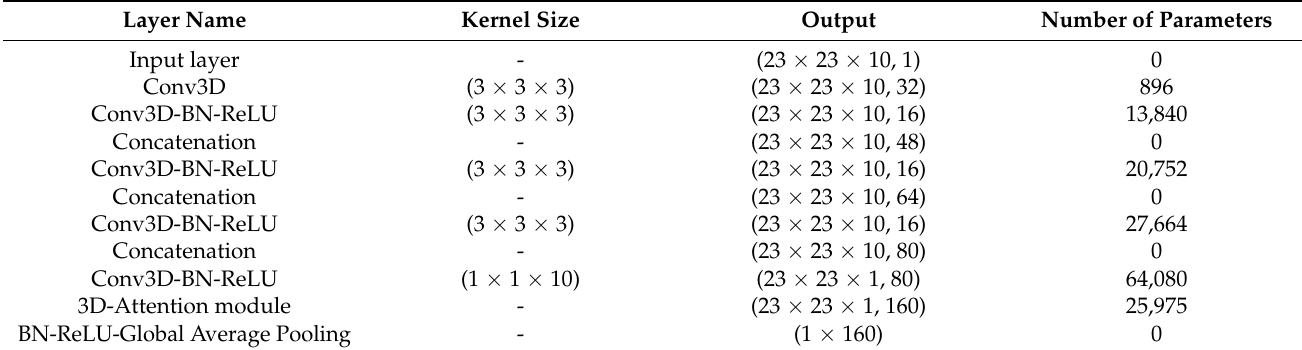
Table 5. Details of the 3D-DenseNet with dual attention.